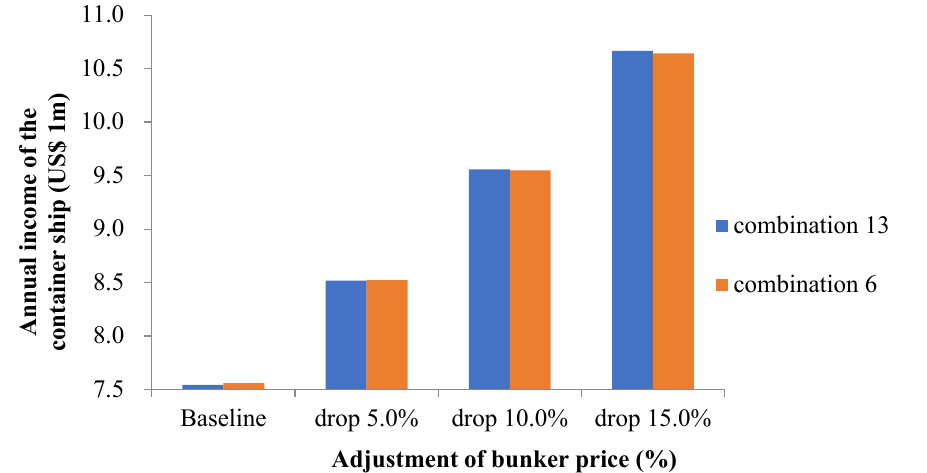
Figure 4. Annual net income for combination 6 and combination 13 when the percentage of bunker price drops to a certain point.